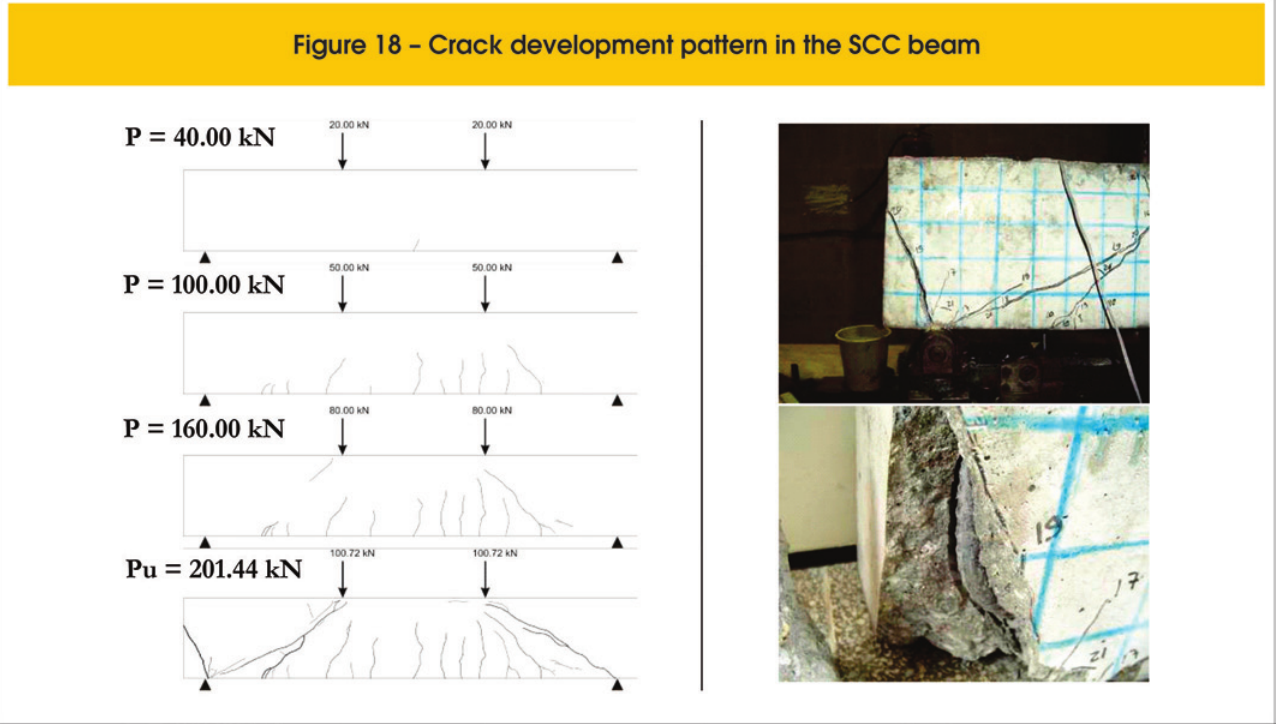
Figure 19 reveals that the incorporation of steel fibers into the SCC avoid - ed slipping of the longitudinal reinforcement in the beam support region, in contrast with what occurred in the case of the SCC beam (Figure 18).